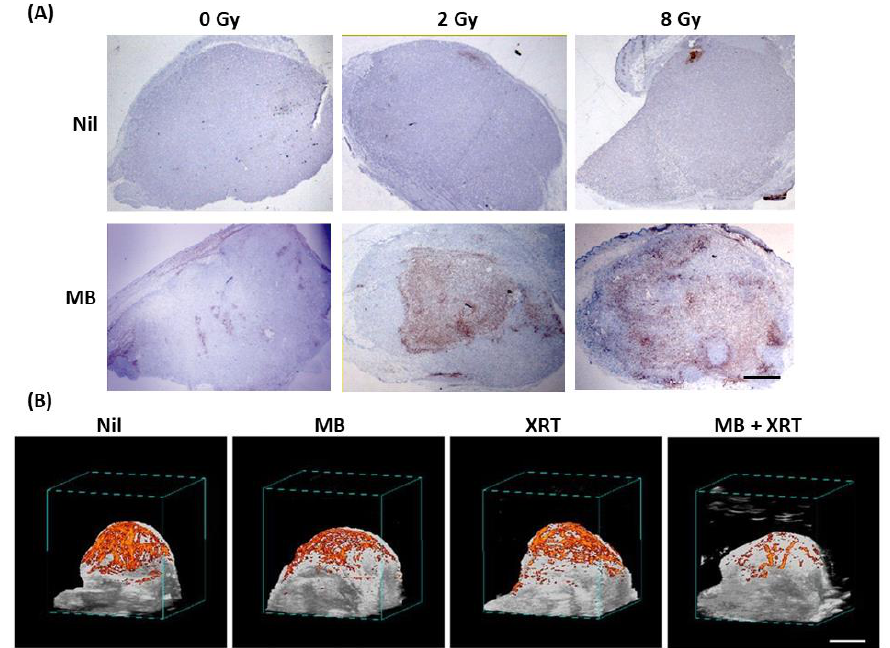
Figure 6. In vivo cell death staining of sections of PC3 prostate tumours and power Doppler ultra- sound imaging for radiation and ultrasound treatments. ( A ) Image depicts assessments of cell